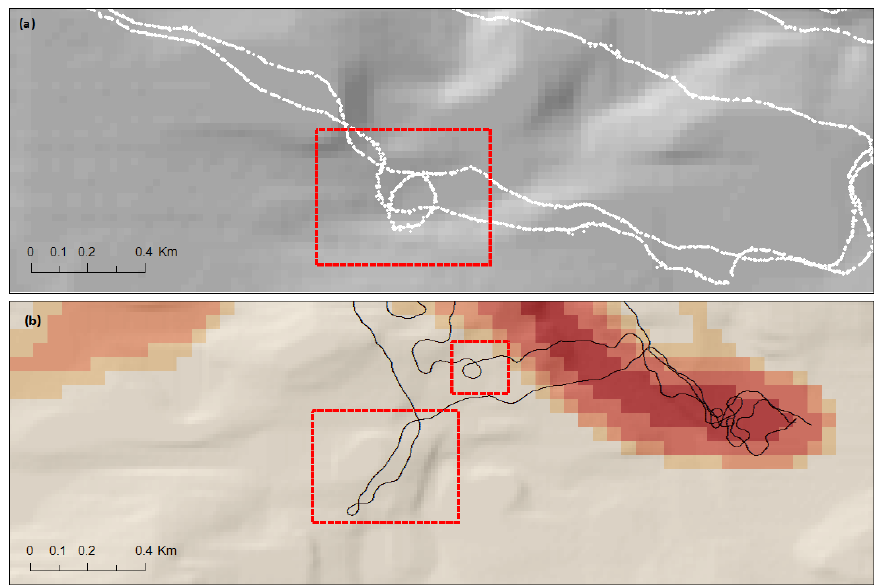
Figure 6. Loops in flight paths as reproduced by optimized model parameters ( a ); loops as captured in the empirical data ( b ).